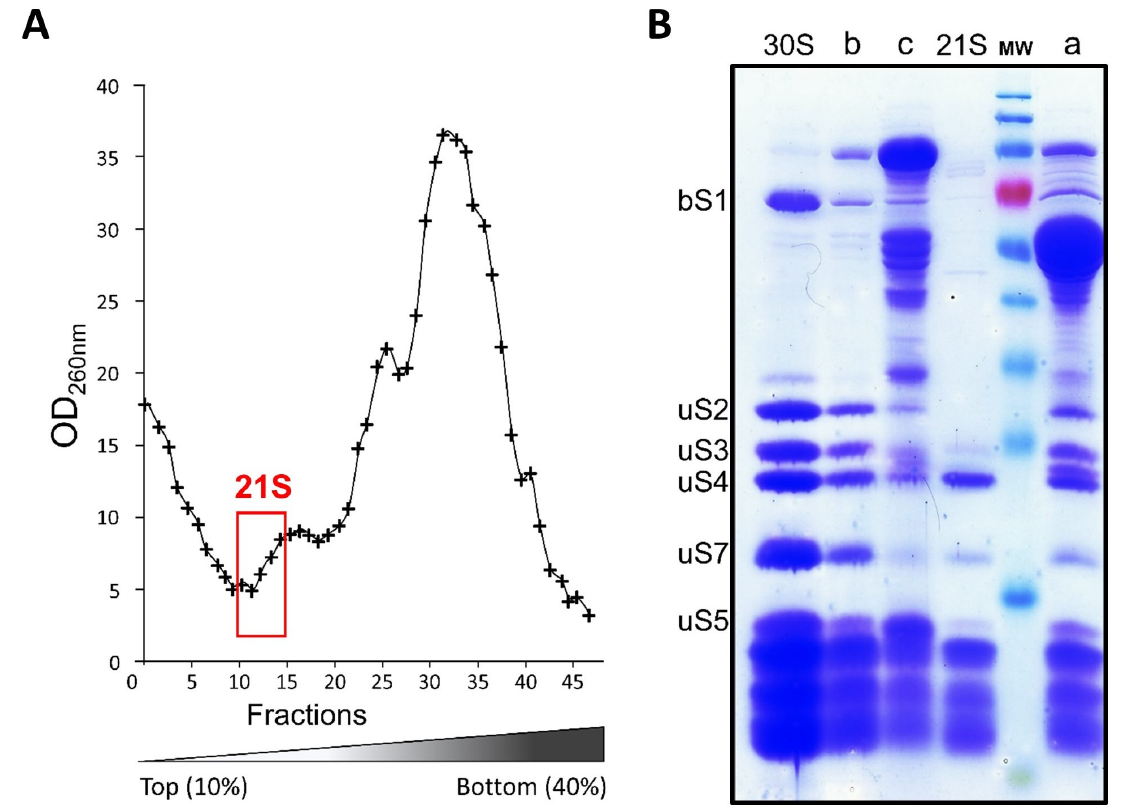
Figure 3. Purification of 21S particles. ( A ) Escherichia coli E6006 cells were grown in M63 medium and subjected to heat shock for 1 h at 45 ◦ C. The clarified supernatants were loaded onto a 10–40% ( w / v ) linear sucrose gradient, and the sucrose density gradient profile is shown here. The fractions corresponding to 21S are outlined in red. ( B ) These fractions (“a”) were pooled, while 30S subunits were retained on NiTa resin and eluted with imidazole (“b”). The flow-through was applied to streptactin resin and eluted with desthiobiotin (21S), with the non-retained fraction (“c”) and the molecular weight (MW) markers shown. The bands corresponding to the ribosomal proteins bS1, uS2, uS3, uS4, uS5, and uS7 are also indicated.